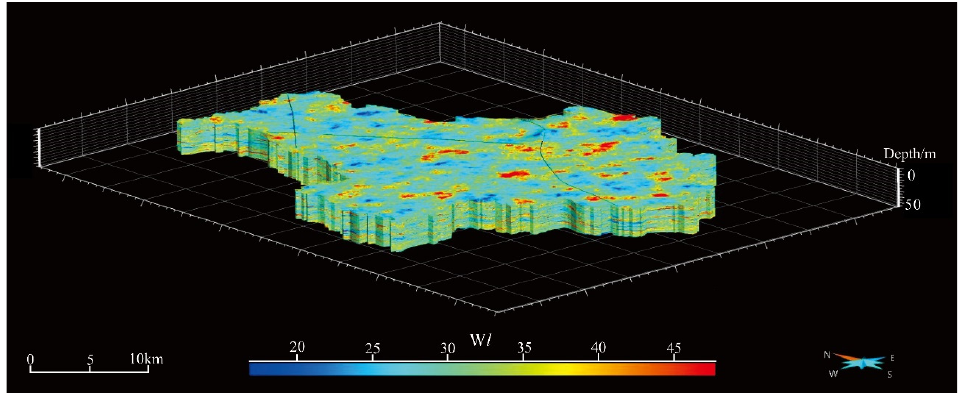
Figure 11. Three-dimensional geological attributed model of subsoils in Tongzhou District (liquid limit).